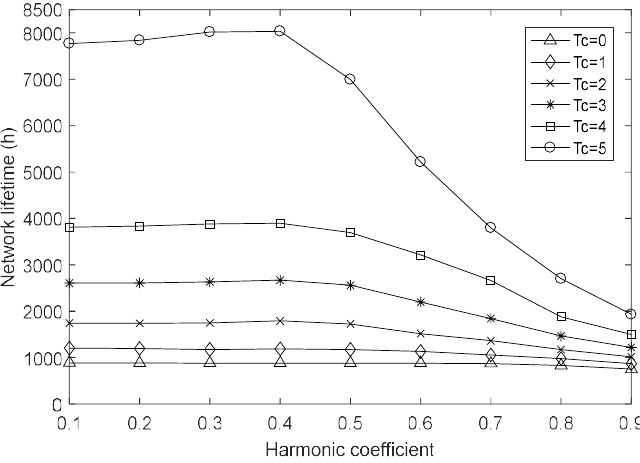
Figure 5. Network lifetime with varying harmonic coefficient.